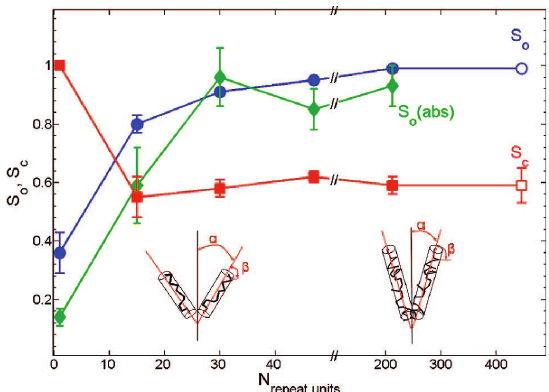
Figure 4. Orientation S and conformation S order parameters as a function of repeat o c units N . Results of an independently measured sample with 423 repeat units are included for comparison (open symbols). Green diamonds are data points from ensemble absorption measurements. Lines are given as guides to the eyes. The cartoon (not to scale) shows chain length. Image and caption reprinted with permission from [64], Copyright 2008